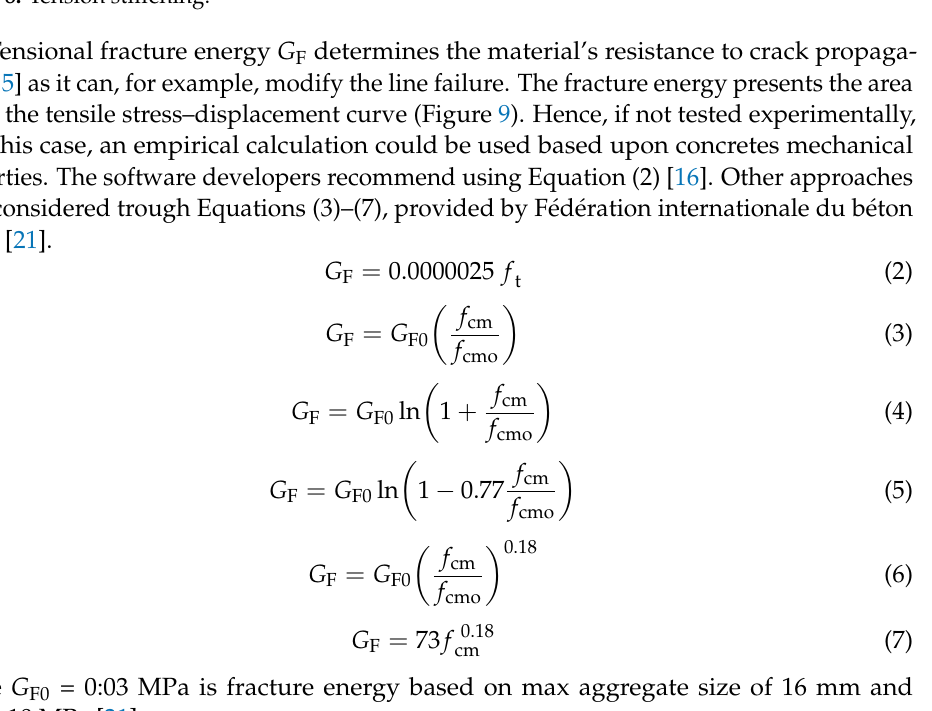
Figure 8. Tension